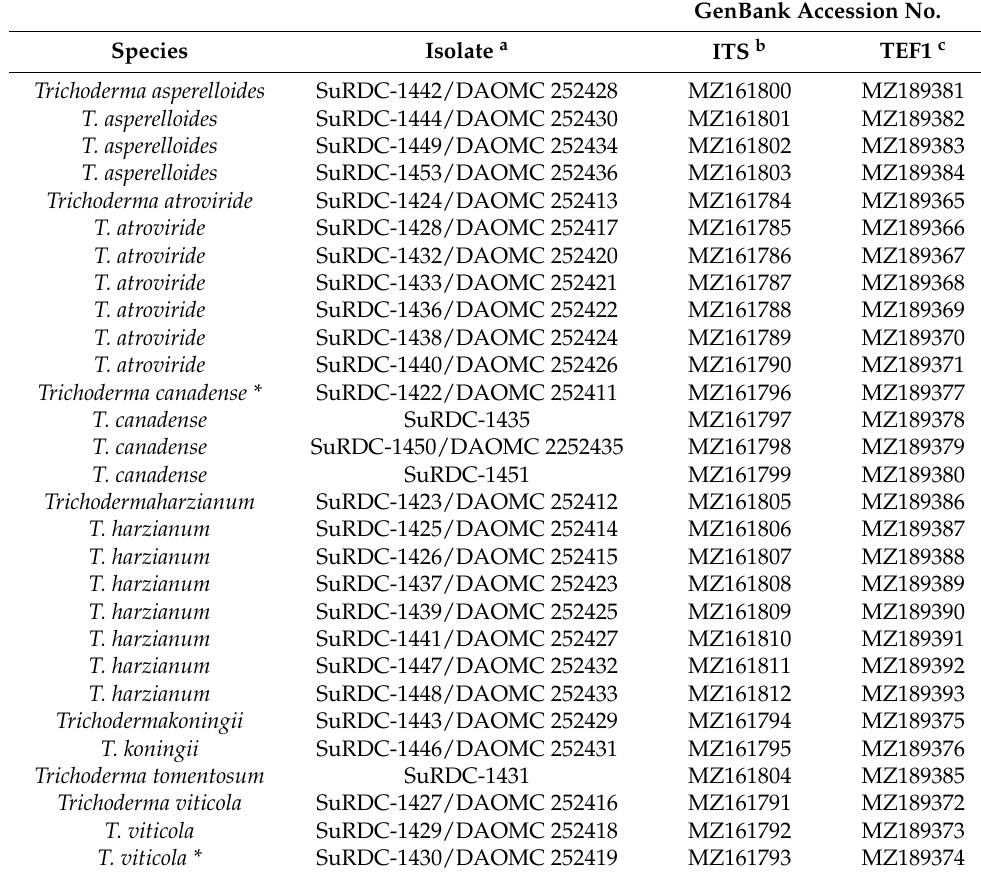
GenBank Accession No.